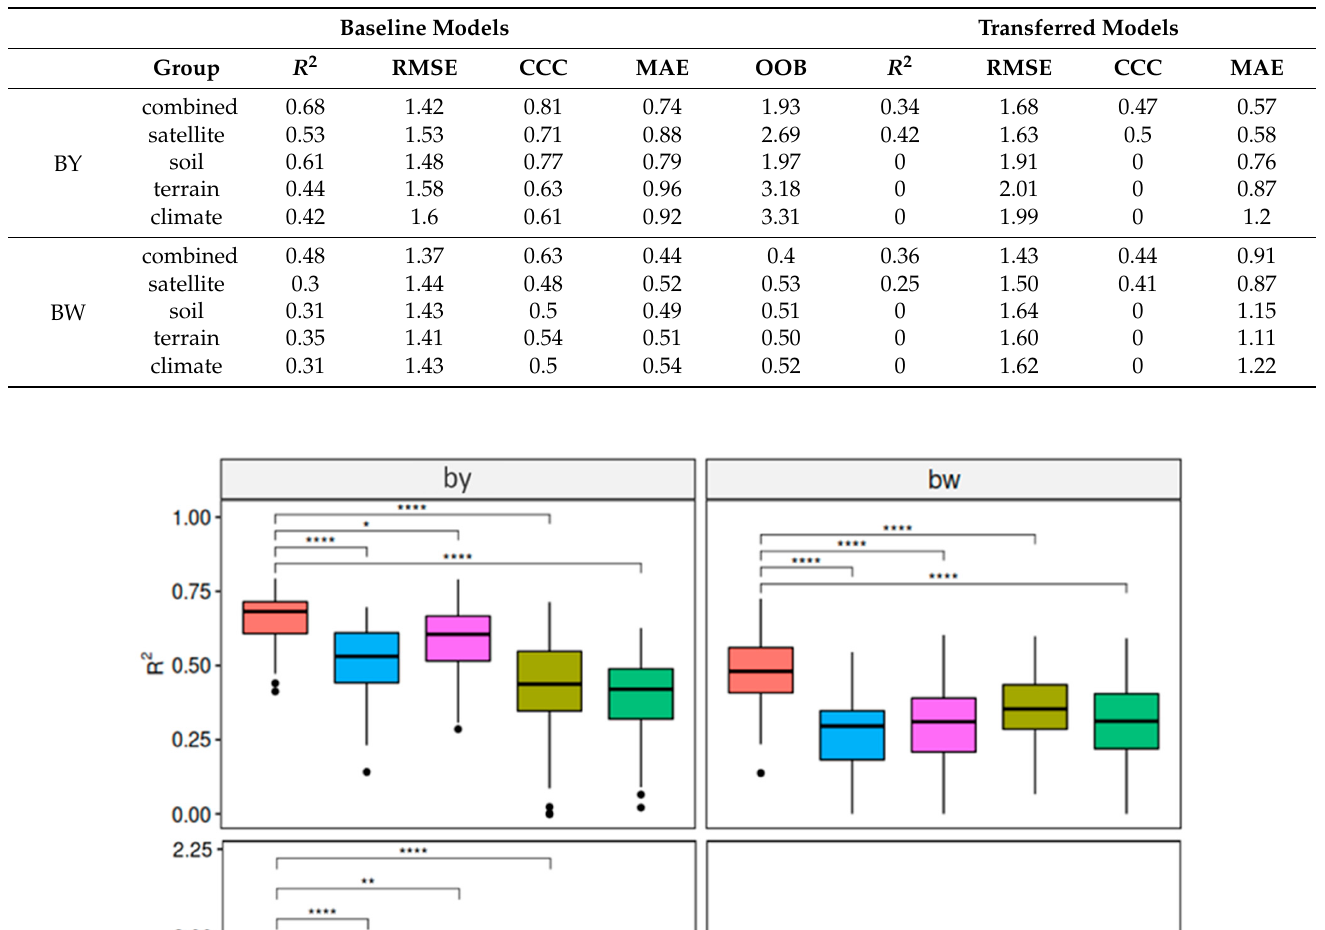
Table 5. Cross-validation results ( R 2 , RMSE, CCC, MAE, and OOB) of the baseline and transferred models in both states.